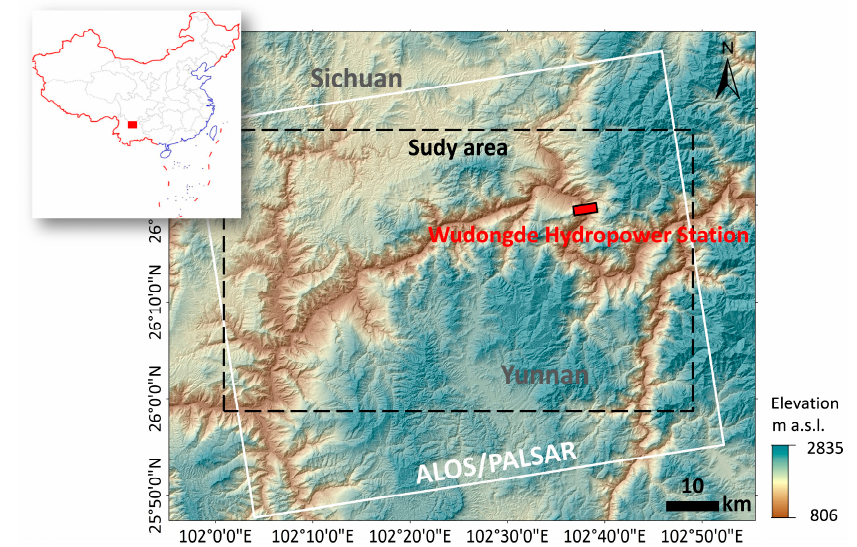
Figure 1. Location of the study area, where the background is the topography map. The inset shows the study area in China.